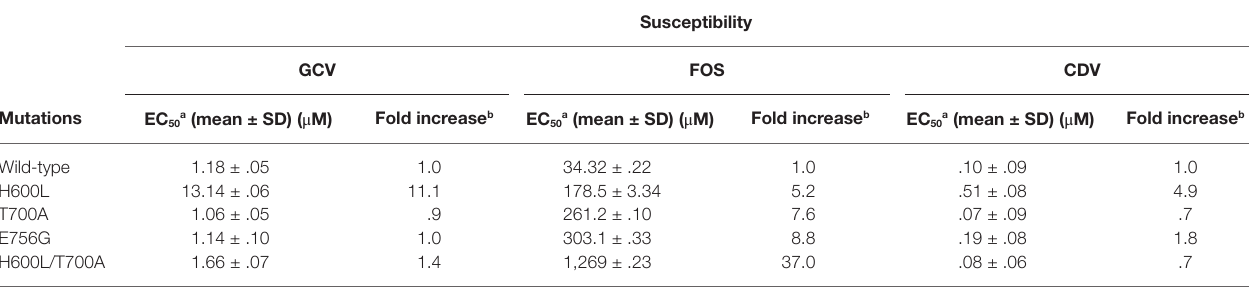
TABLE 2 | Susceptibility of wild type and UL54 mutant viruses to GCV, FOS, and CDV drugs.